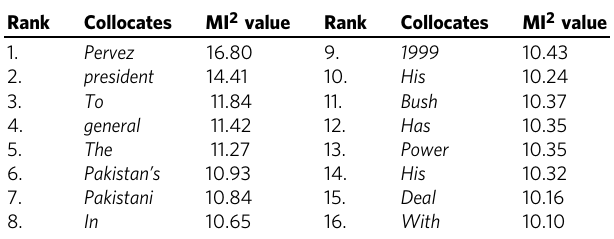
Table 2 Collocates of Musharraf* using T -test (threshold level is